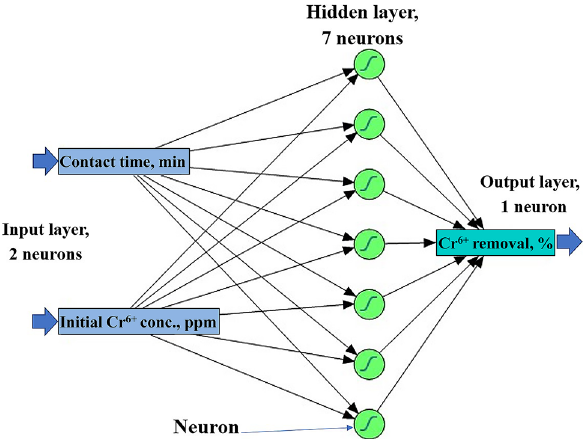
Figure 1. General architecture scheme of the artificial neural network containing one input layer (2 neurons), a hidden layer (7 neurons), and an output layer (one